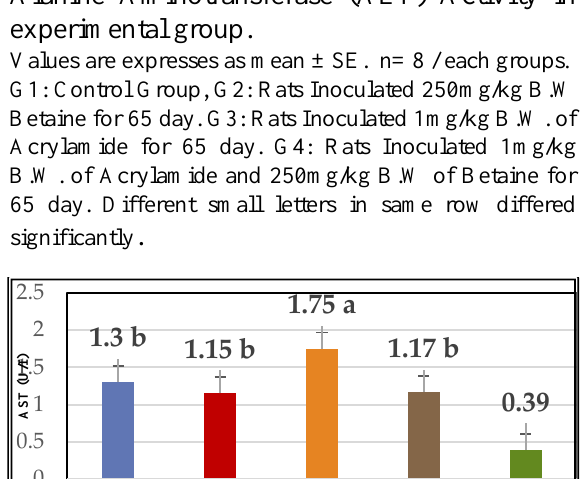
Figure 1: Effect of betaine intubation on serum Alanine Aminotransferase (ALT) Activity in experimental group.